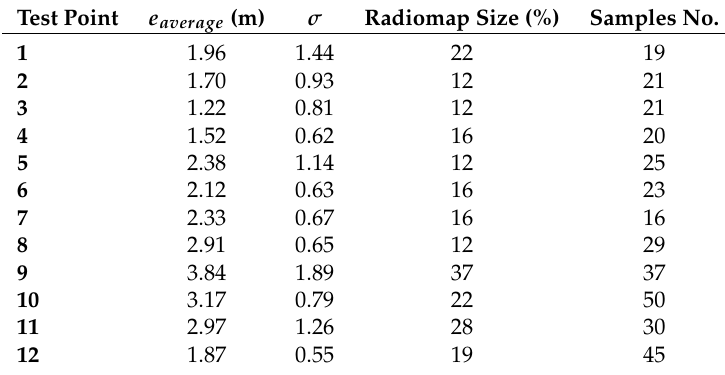
Table 5. Positioning error of combined BLE (all deployed BLEs) and Wi-Fi RSS fingerprint-based positioning